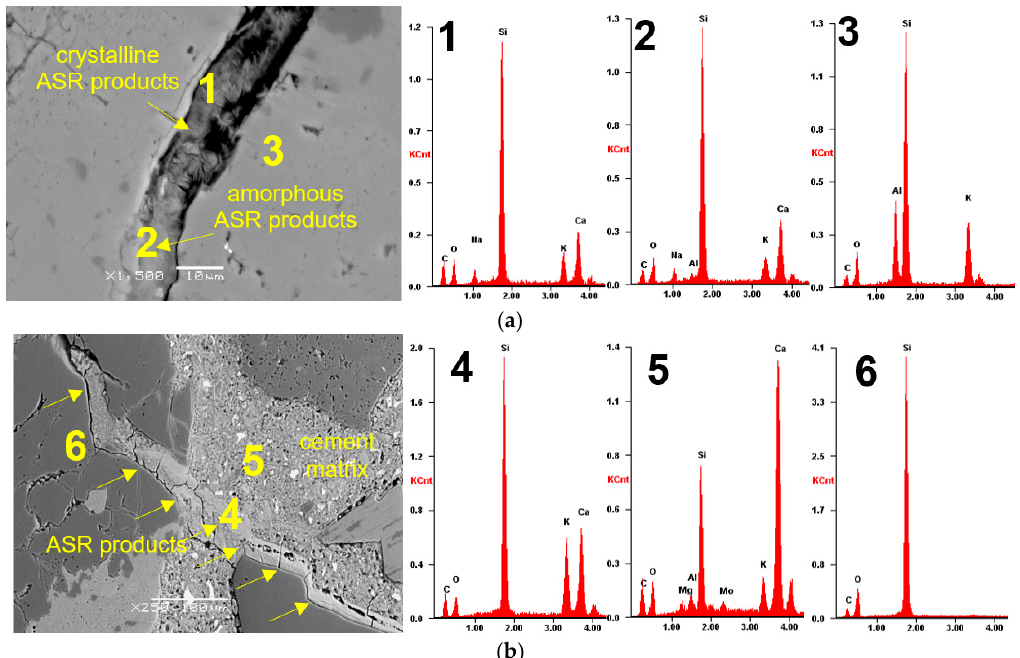
Figure 5. Microstructure of the mortar with aggregate G2 after 28 days of storage at 80 °C in ( a ) 1 M NaOH, crack in the aggregate grain filled with crystalline (1) and amorphous (2) ASR products, (3) potassium feldspar; ( b ) 50% HCOOK, crack in the aggregate grain filled with ASR products that penetrates the cement matric (5), C-S-H (5), quartz (6).